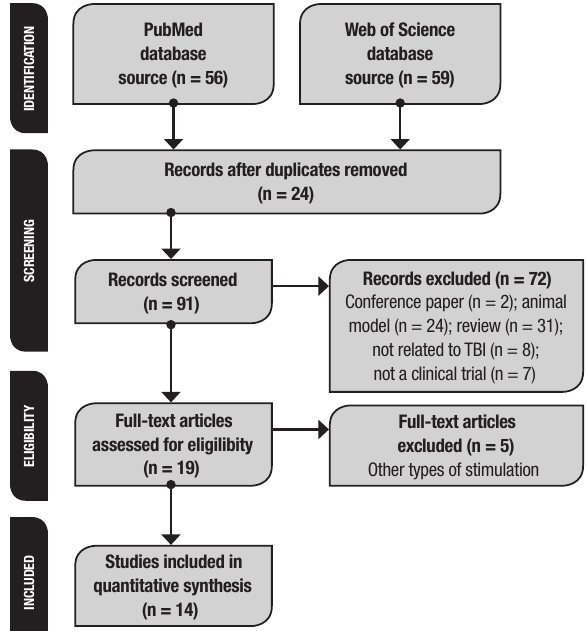
Figure 1. Flow diagram following Prisma